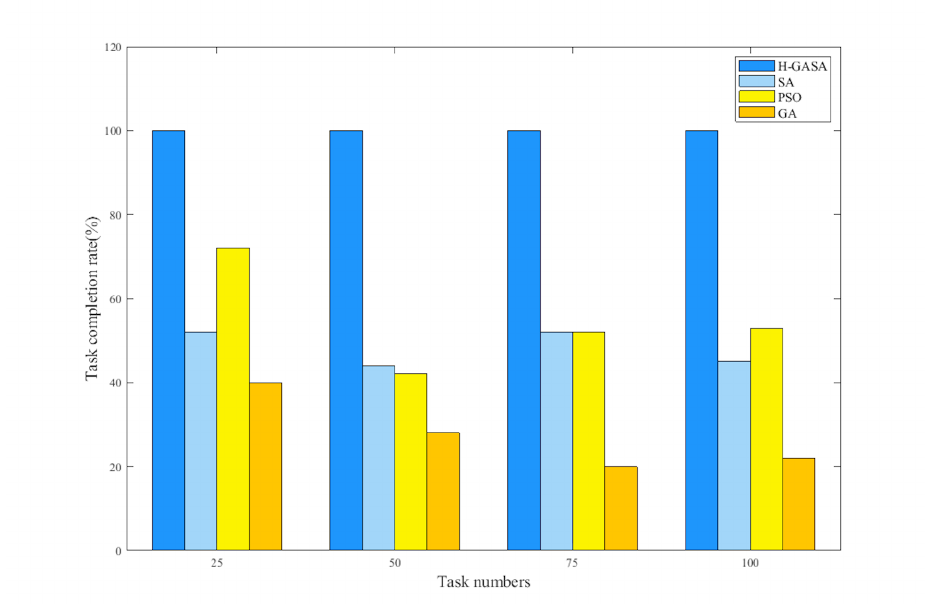
Figure 10. Task completion rate of comparison